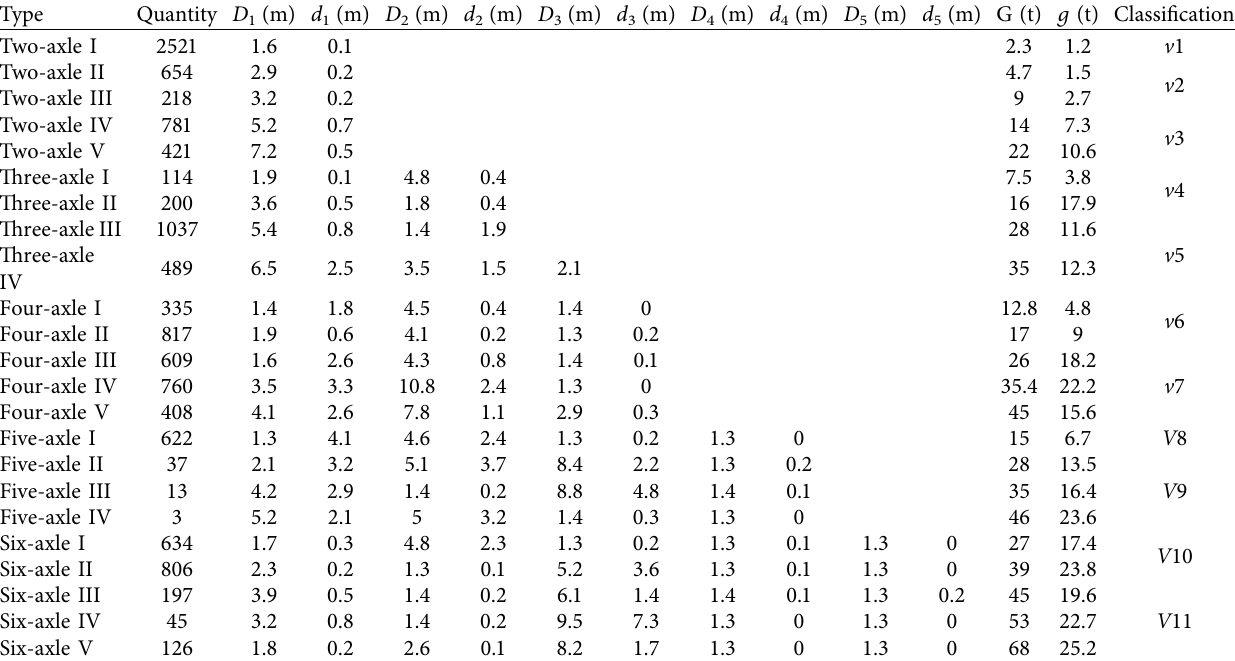
Table 1: Vehicle